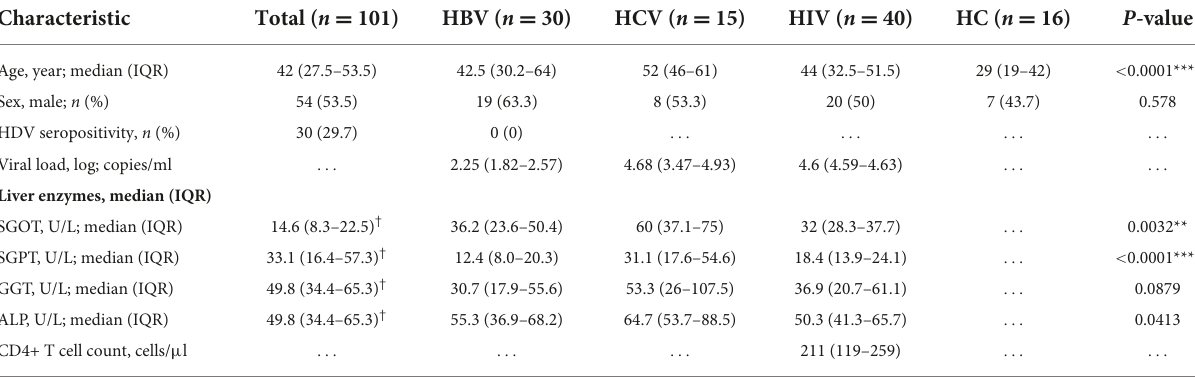
TABLE 1 Clinicodemographic characteristics of study